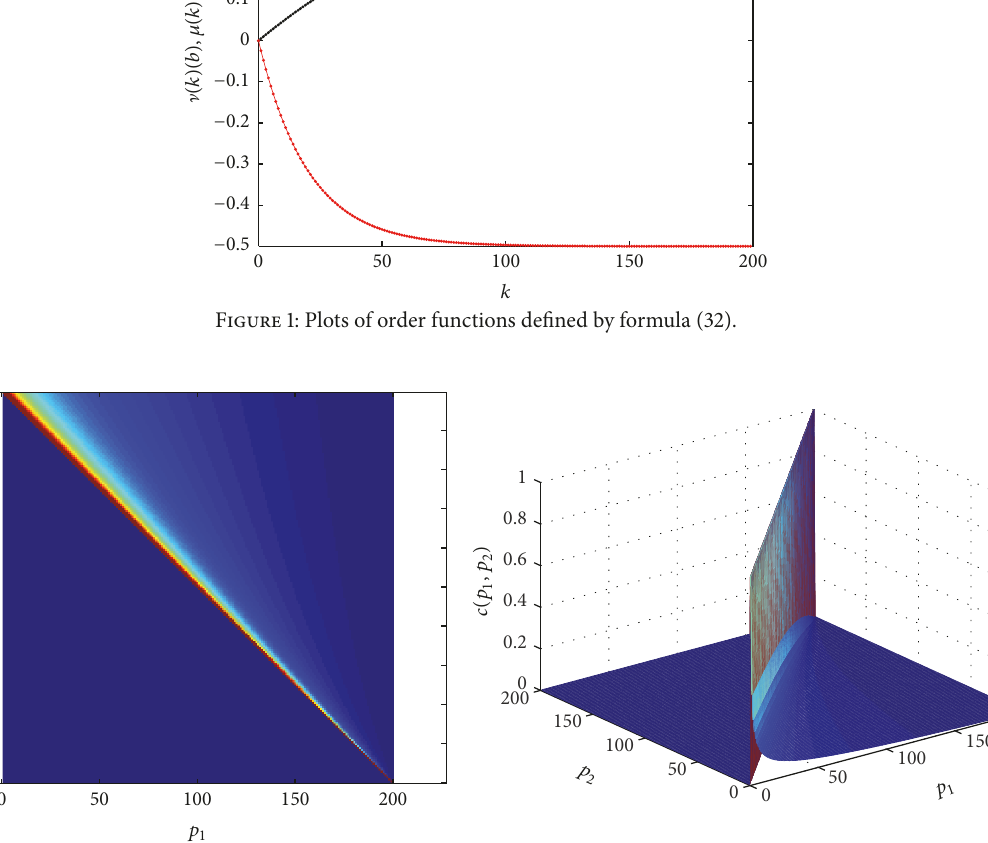
Figure 2: Image of the matrix and 3D plot of values of the matrix [ 𝑘